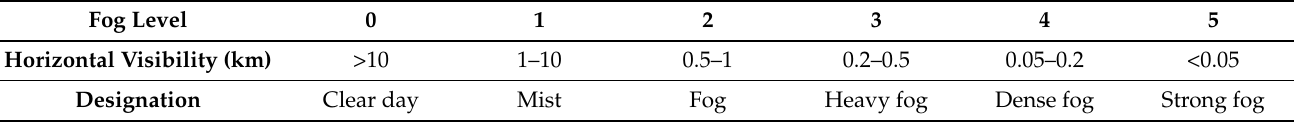
Table 1. Relationship between fog level and horizontal